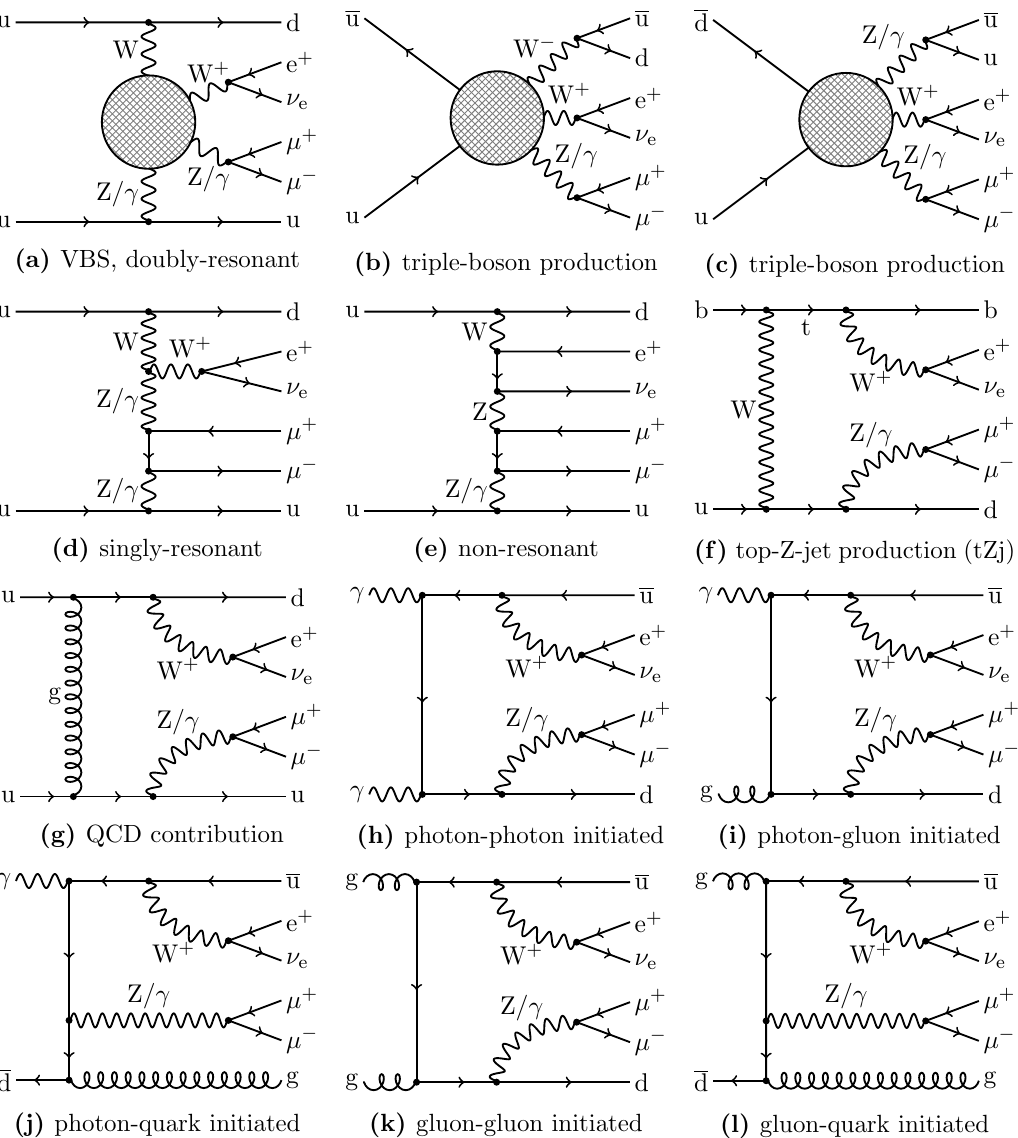
Figure 1. Examples of LO Feynman